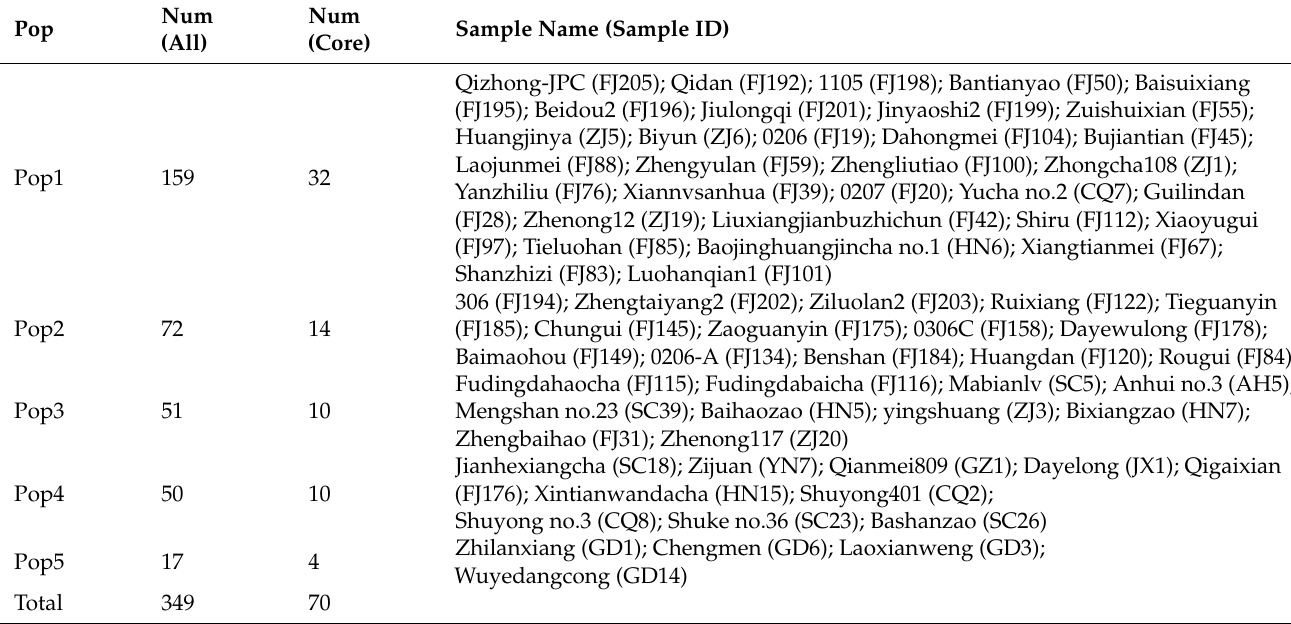
Table 2. Analysis of core varieties in 5 populations.